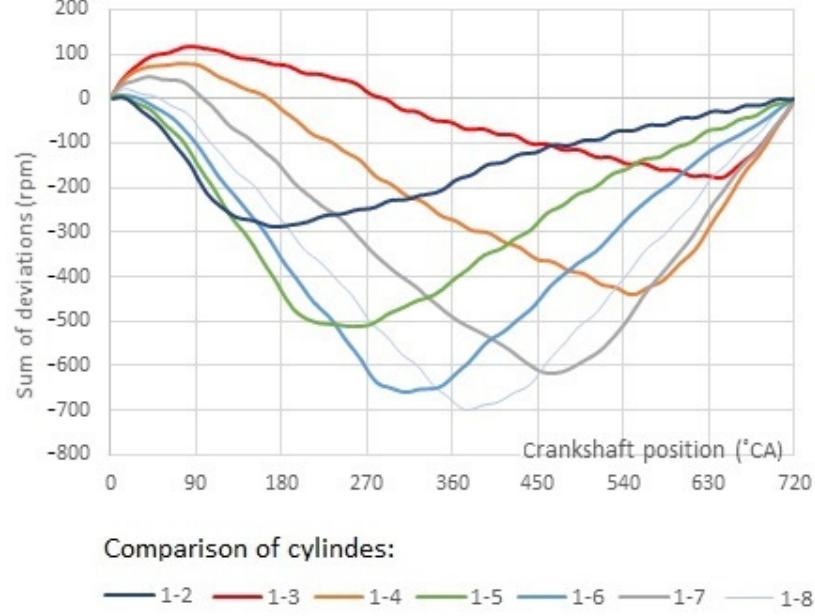
Figure 7. Summary deviations of rotational speed with a crankshaft rotation function for a Buckau-Wolf R8DV-136 engine.